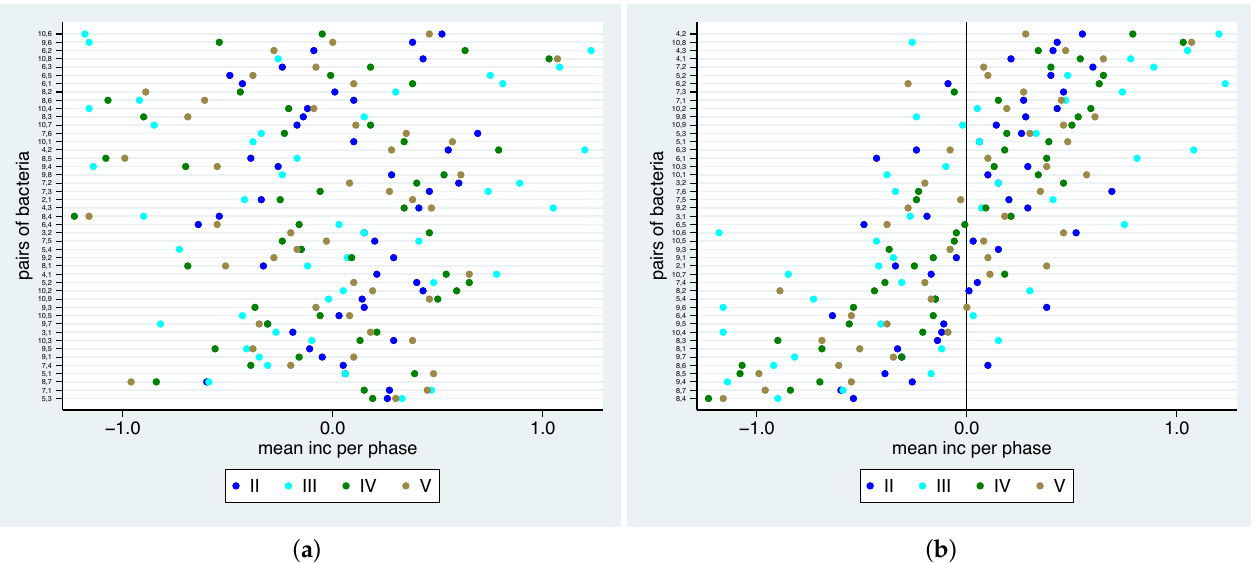
Figure 7. Mean values for phase-based log ratios for changes for all pairs of bacteria and phases sorted by range ( a ) and mean ( b ).